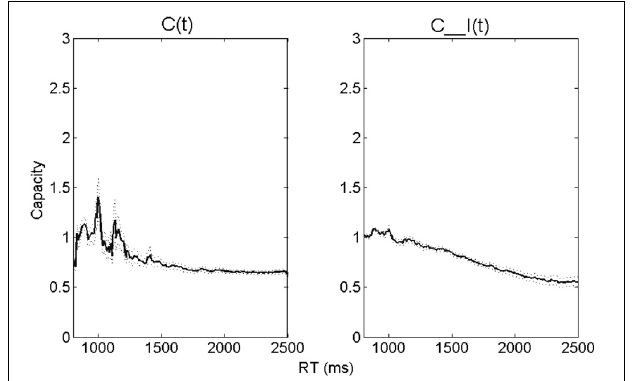
FIGURE 2 | A similar figure is displayed in Altieri and Hudock (2014), after some listeners with mild hearing impairment (thresholds > 25dB) were removed ( n = 39). It shows mean capacity-integration efficiency measures (thick solid line = Capacity/Integration Efficiency). The left panel shows C(t) , and the right panel shows C_I(t) . The dotted lines show one standard error (SE) of the